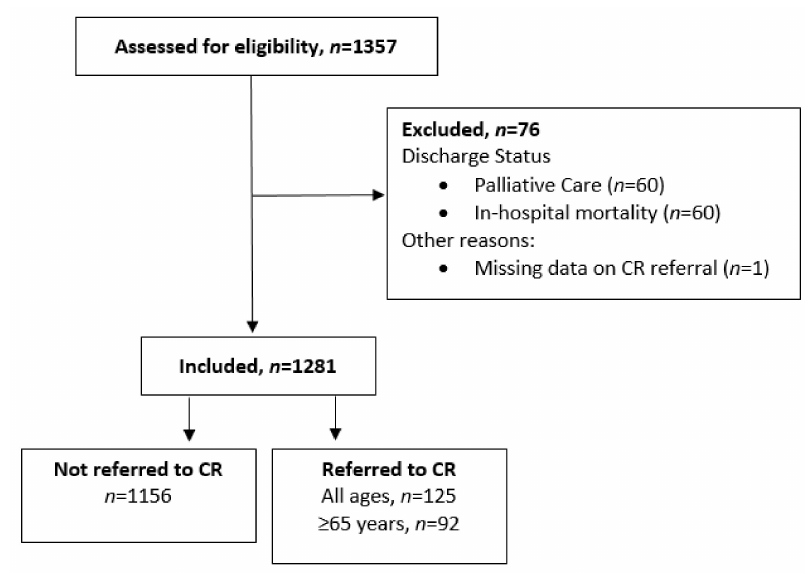
Figure 1. Study flow and referral to Cardiac Rehabilitation (CR). Table 1. Select baseline patient characteristics among all patients and those referred and not referred to cardiac